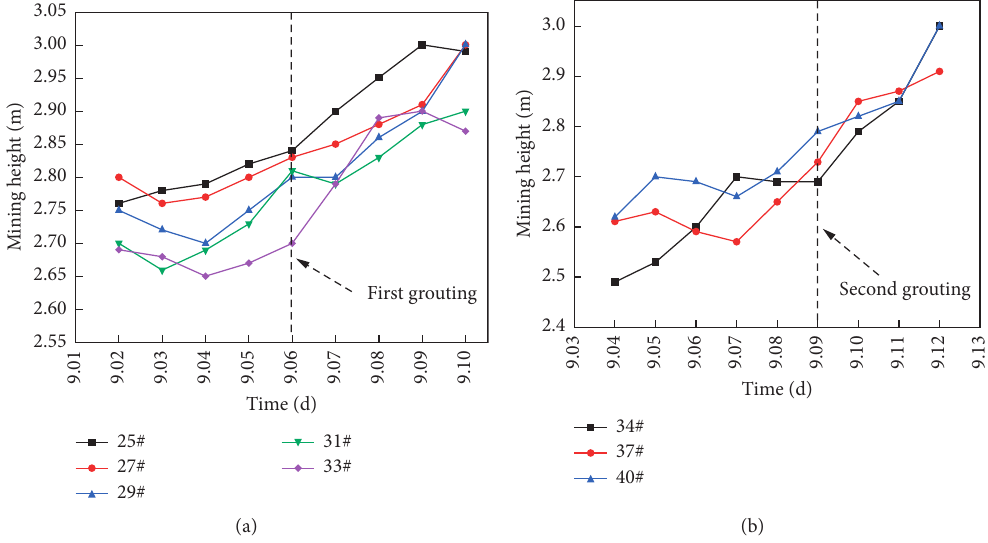
Figure 15: The mining height before and after two grouting: (a) First grouting. (b) Second